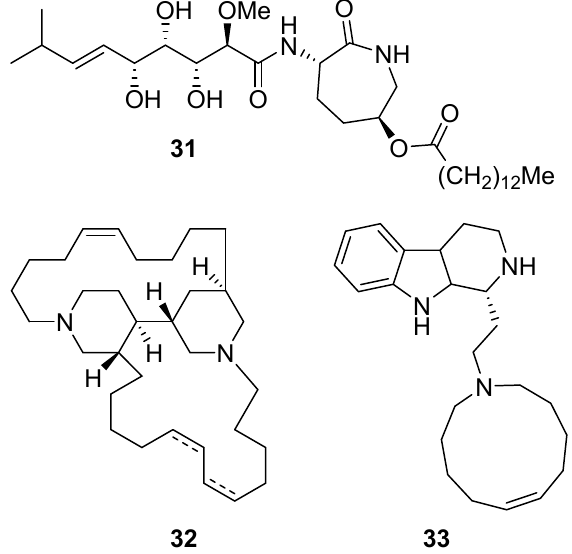
Figure 13. Structures of bengamide A ( 31 ), haliclonacyclamines A + B ( 32 ), keramamine C ( 33 ). Phenylspirodrimane, stachybotrin D ( 34 , Figure 14) isolated from the sponge-derived fungus inhibitory effects on the wild type (EC 50 8.4 µM) and five NNRTI-resistant HIV-1 strains (EC 50 7.0; 23.8; 13.3; 14.2; 6.2 µM) [101].